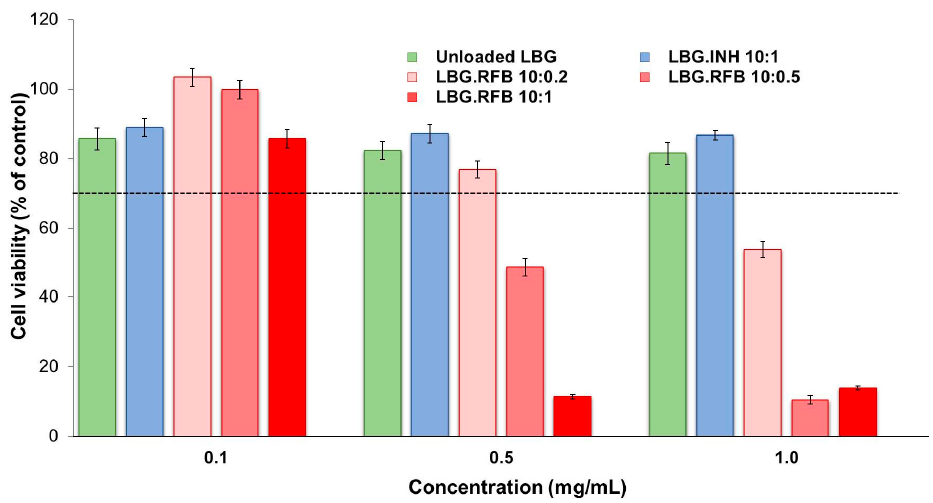
Figure 7. THP-1 cell viabilities after 24 h of exposure to LBG-based microparticle formulations. Results are expressed as mean ± SEM ( n = 3, six replicates per experiment at each concentration). Dashed line represents 70% cell viability (INH: isoniazid, LBG: locust bean gum, RFB: rifabutin).